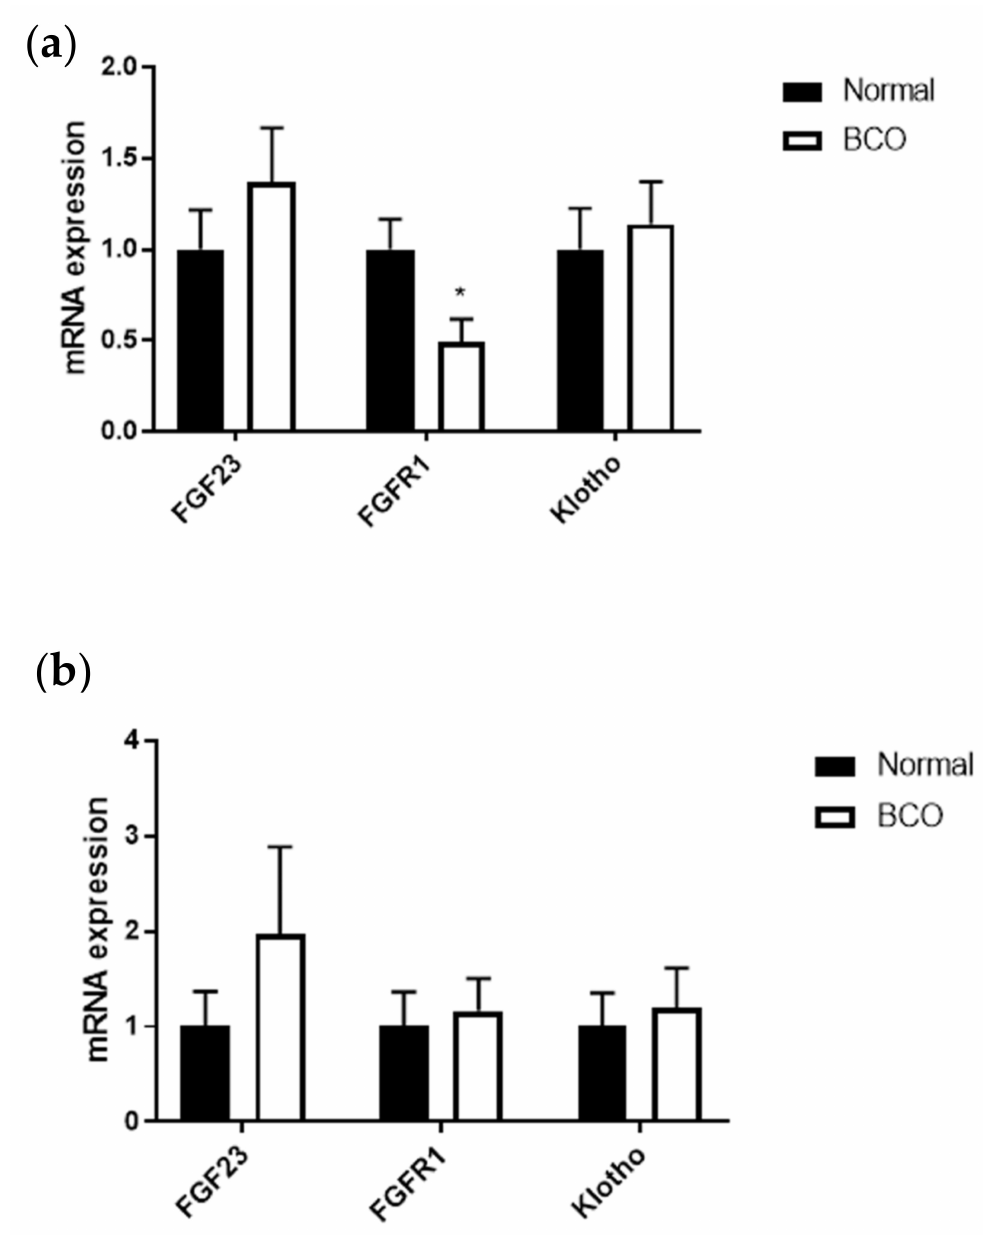
Figure 5. Local and systemic expression of key FGFs in normal and BCO-affected broilers. Gene expression for FGF23 , FGFR1 , and Klotho in the bone ( a ) and blood ( b ) of normal and BCO-affected broiler chickens. Significance was determined using a student t -test with p -value < 0.05. * indicates a significant difference between normal and